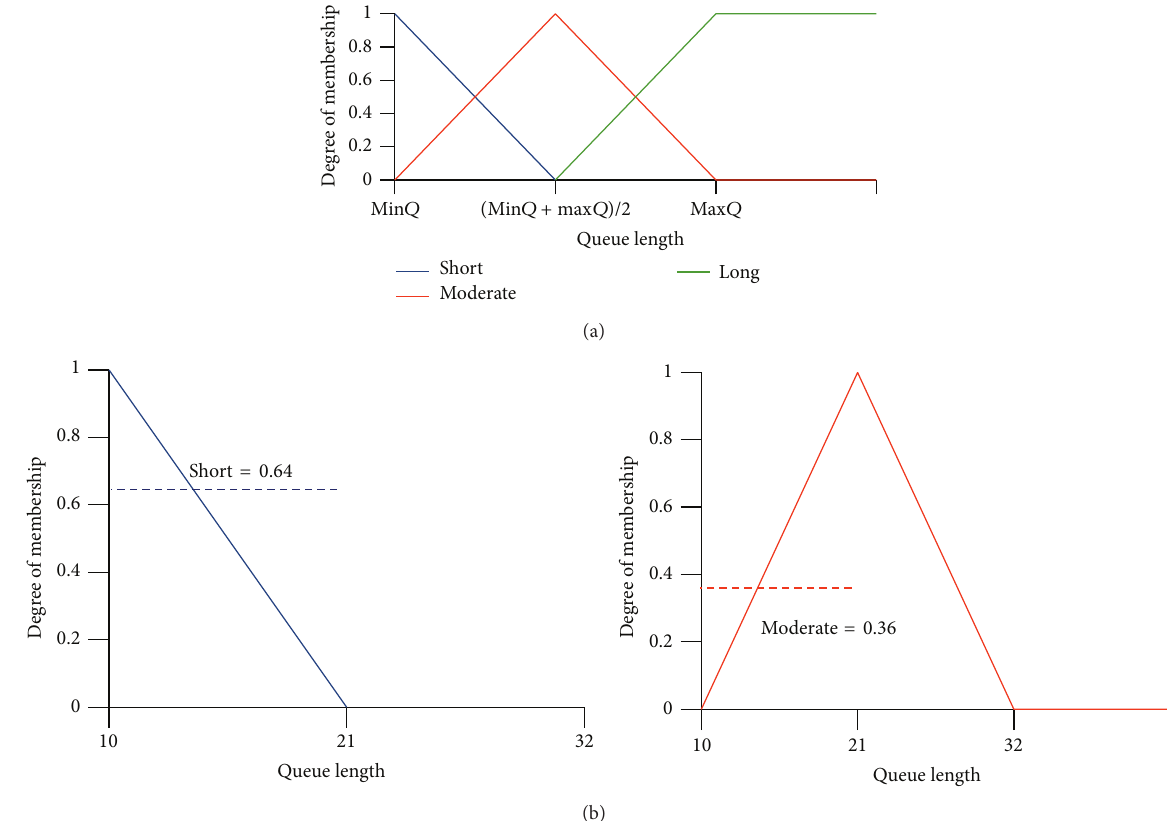
Figure 3: Membership diagram for queue length. (a) and (b) Degree of membership for short and moderate with input myqlen = 14 , min 𝑄 = 10 , and max 𝑄 = 32 .